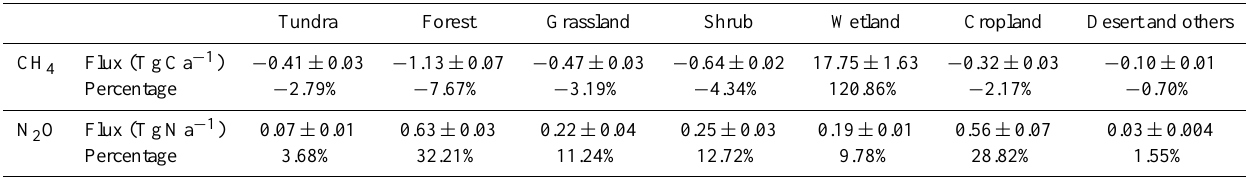
Table 6. Biome contributions to the terrestrial fluxes of CH 4 and N 2 O over continental North America (The fluxes are shown as mean plus and minus standard deviation). Tundra Forest Grassland Shrub Wetland Cropland Desert and